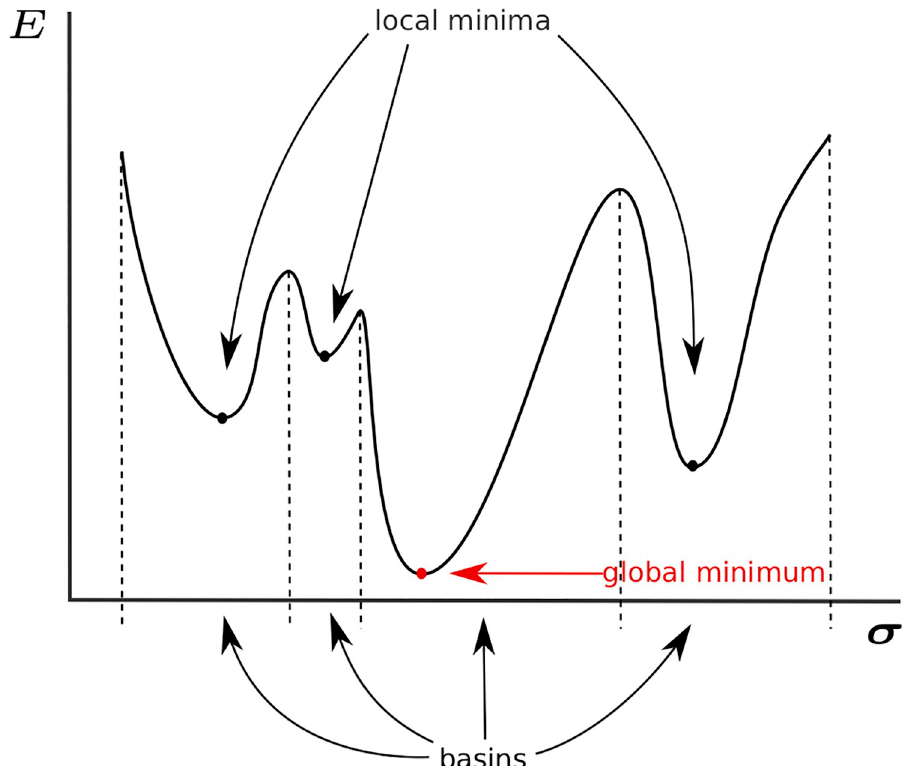
Fig 4. A rugged energy landscape is characterized by the presence of local minima, where proteins sequences can get stuck during the evolutionary process. The set of sequences that evolve to a given local minimum defines the basin of attraction of that